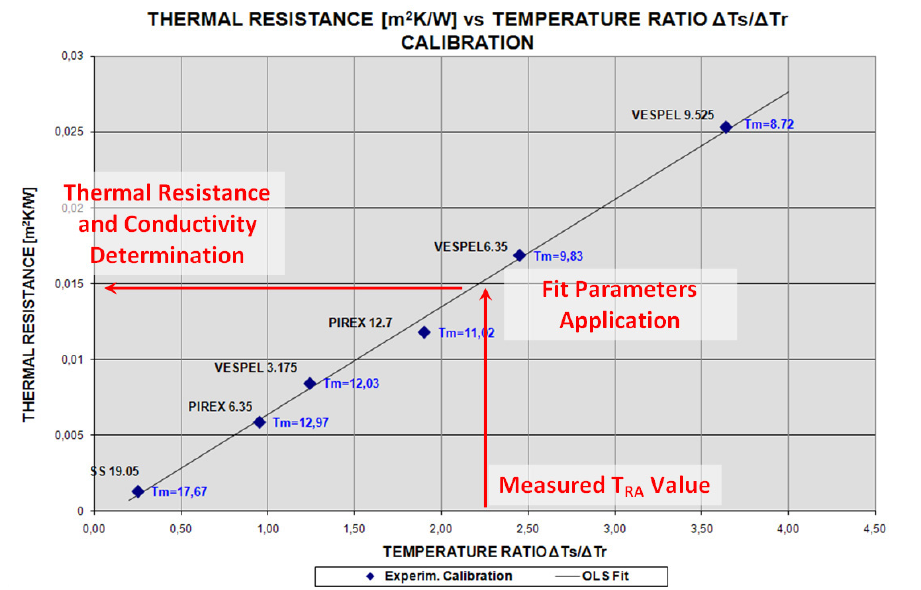
Fig. 4. (Color online) Thermal Conductivity determination for specimens of unknown thermal